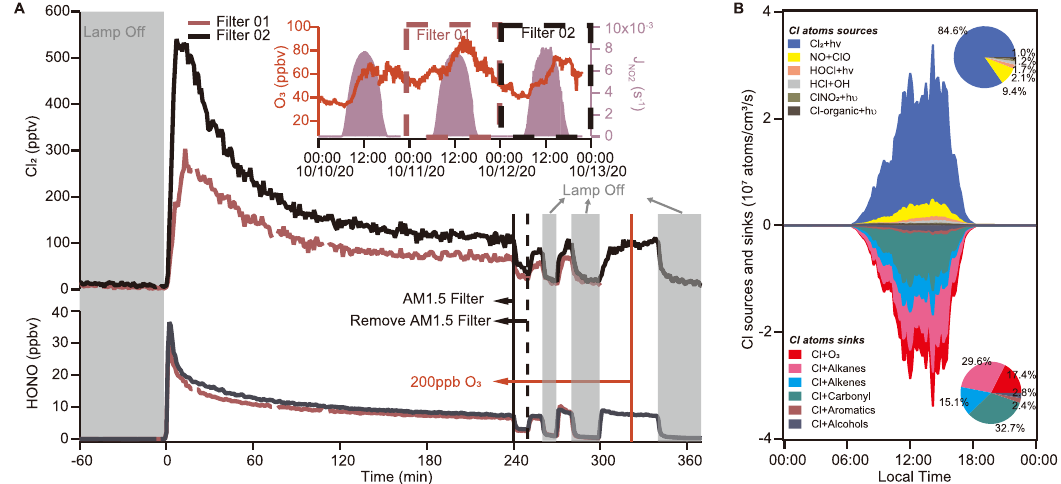
Fig. 3 Experimental results on ambient aerosols and model results of Cl atoms budget. A Experimental results on ambient aerosols in the dynamic chamber. Time series of 1-min average Cl 2 and HONO. Ambient samples (cropped size: 60 mm × 60 mm, Fig. S7C) were illuminated at t = 0. The grey area indicates the period, which the xenon lamp was turned off, the solid black line shows the time at which the AM1.5 fi lter was used, the black dashed line indicates the time at which the AM1.5 fi lter was removed, and the solid red line indicates the time at which 250 ppbv O 3 was added. The right inset: ambient observations of O 3 and J NO2 during the ambient aerosol collection in October 2020. Experimental conditions: 75 − 83% RH and 298 K in air. B The model-calculated average diurnal pro fi les of sources and sinks of the Cl atom for period 4 − 14 September 2018. Upper right inset: the daytime average contribution from different sources to Cl atom. Bottom right inset: the average daytime contribution from different sinks to Cl